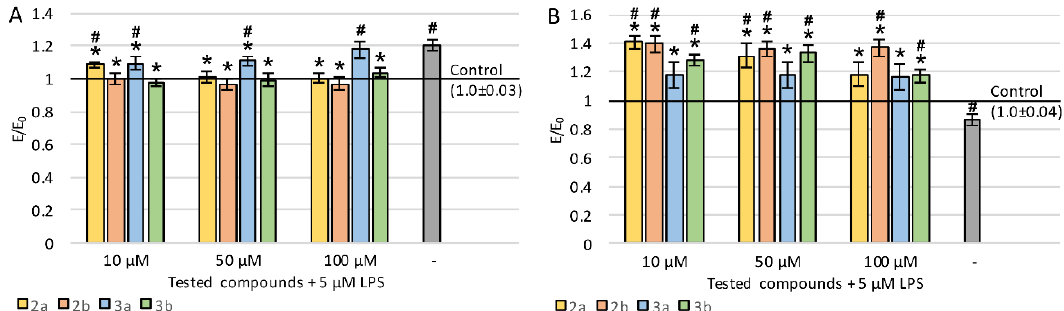
Figure 3. Effect of tested compounds on PC12 cells preincubated with lipopolysaccharide (LPS): A ) cell viability measured in LDH assay, B ) metabolic activity measured in MTT assay; Control—cell culture incubated without LPS and tested substances; * p < 0.05—significant difference compared to control preincubated with LPS; # p < 0.05—significant difference compared to the negative control without LPS.